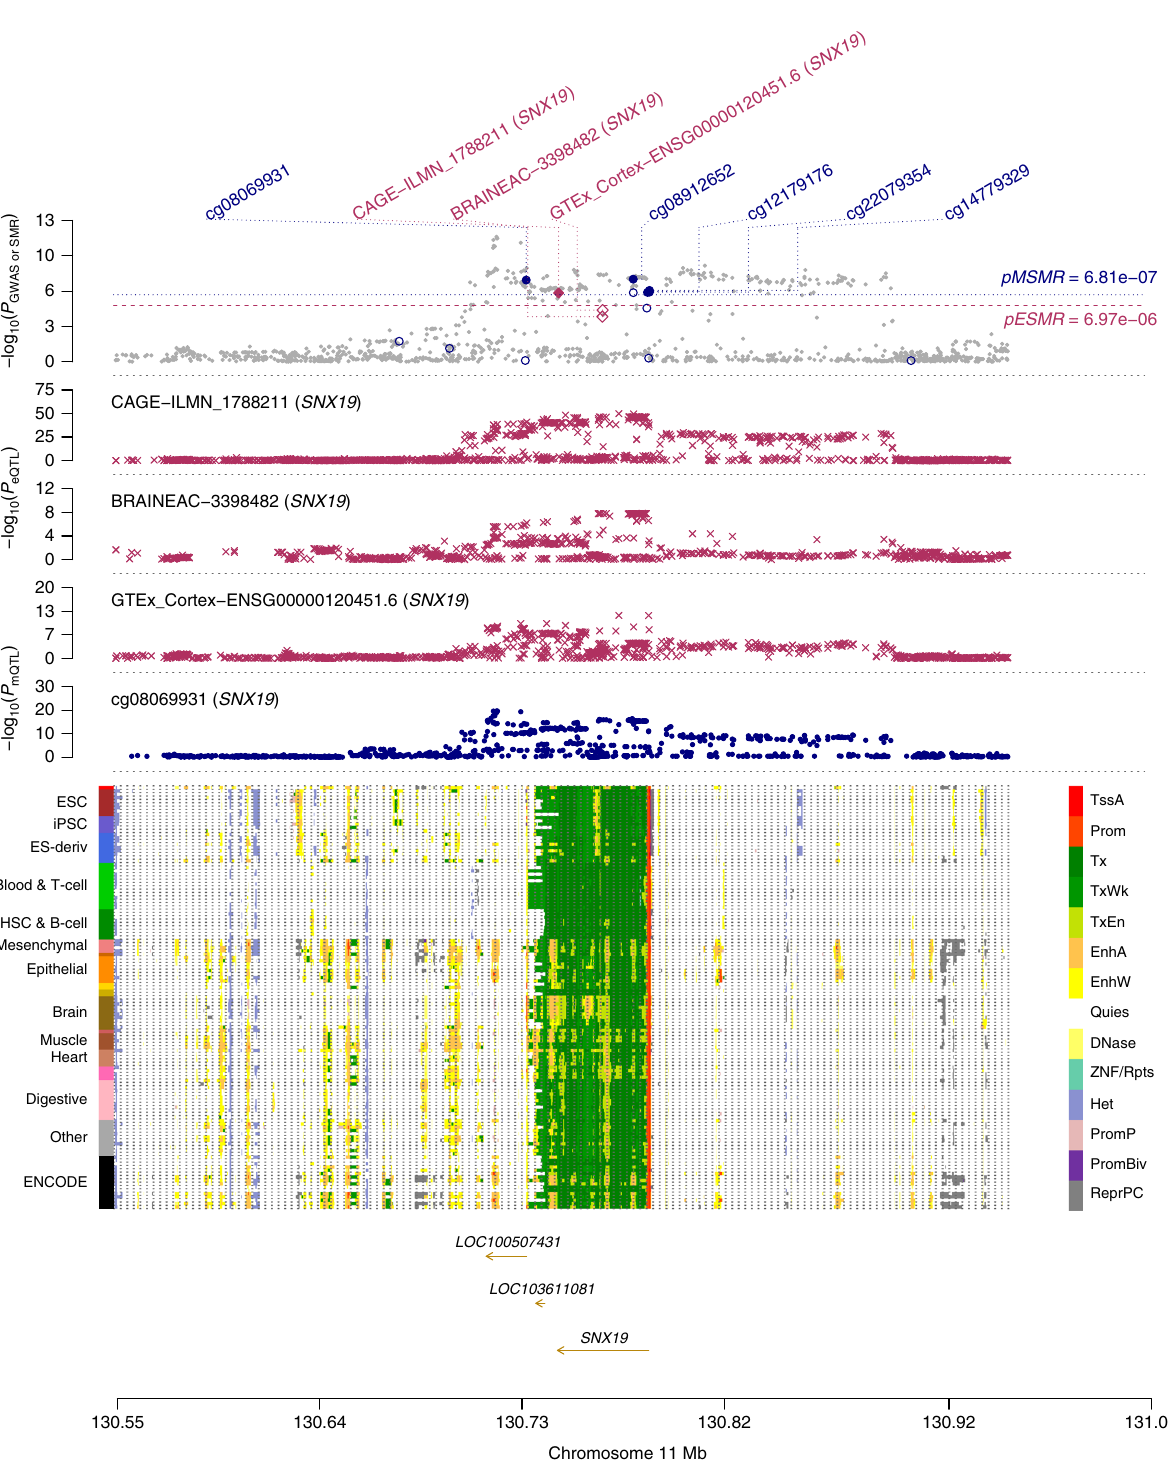
Fig. 6 Replication analysis in the SNX19 locus for schizophrenia (SCZ). The top plot shows − log 10 ( P- values) of the SNPs from the GWAS meta-analysis for SCZ 36 . The red diamonds and blue circles represent − log 10 ( P- values) from the SMR tests for associations of gene expression and DNAm probes with SCZ, respectively. The solid diamonds and circles represent the probes not rejected by the HEIDI test. Plot #2, #3 and #4 (red crosses) show − log 10 ( P- values) of the eQTL for gene SNX19 from three independent data sets. The plot #5 (blue dots) shows − log 10 ( P -values) of the mQTL for DNAm probe cg08069931. The bottom plot shows 14 chromatin state annotations (indicated by colours) of 127 samples from REMC for different primary cells and tissue types